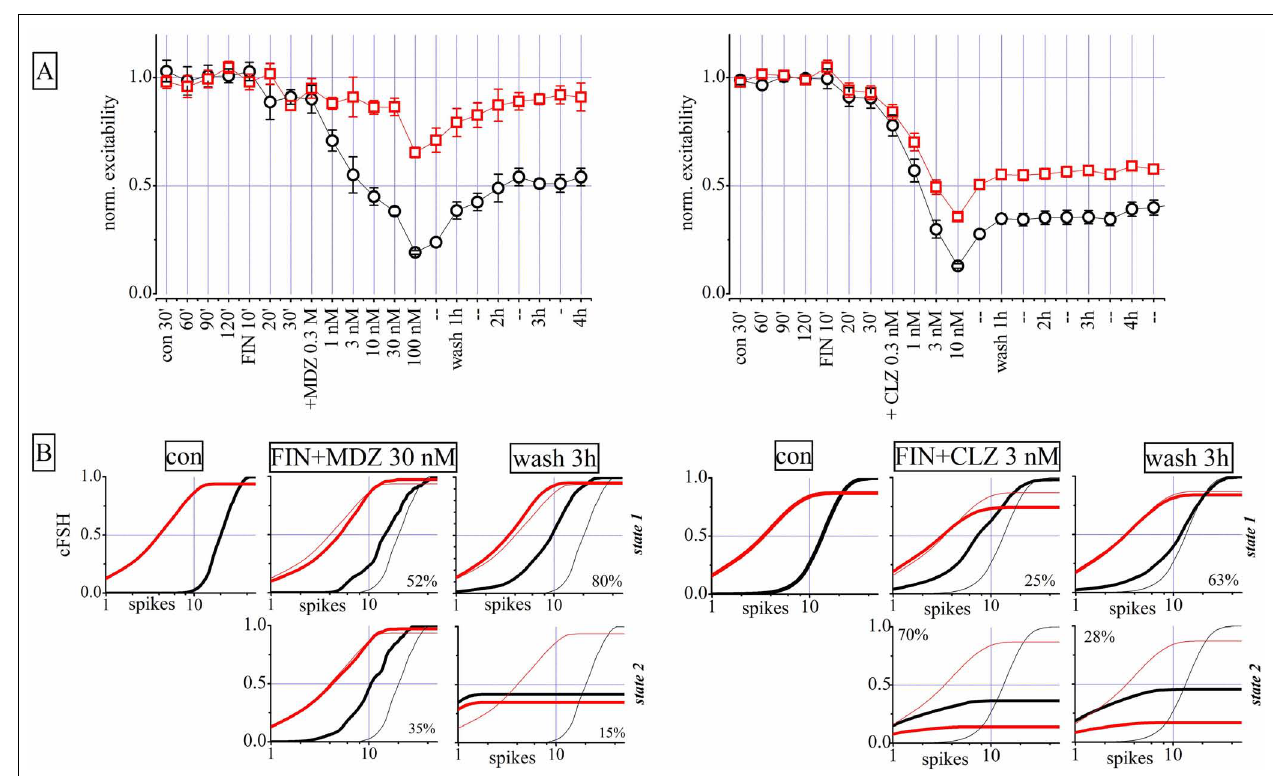
FIGURE 9 | Finasteride (FIN) pre-conditioning did not affect LTD produced by MDZ but induced an LTD effect after CLZ. Left and right parts are related to two different exemplary experiments in which either MDZ or CLZ were applied after FIN, respectively. (A) Plots of normalized global excitability of excitatory (red) and inhibitory (black) neuron clusters in control (four samples of 30 min each), during the treatment with 1 μ M FIN (three samples of 10 min each), after application of increasing concentrations of MDZ (left panel) and CLZ (right panel) and after 1, 2, 3, and 4 h of wash-out.